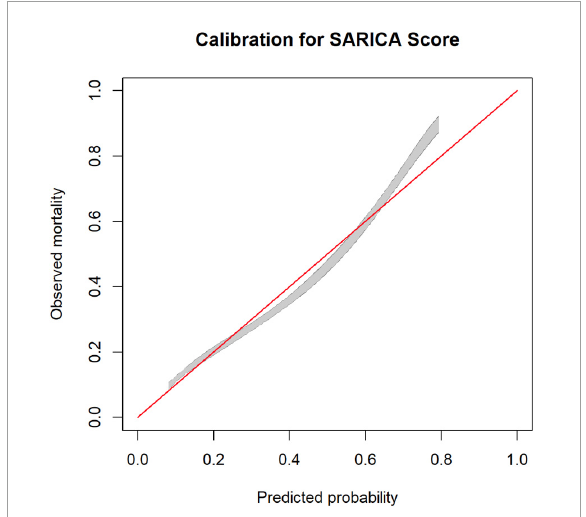
FIGURE3 Calibration plot for SARICA score showing calibration belts (at 80% [gray] and 95% [dark gray] confidence levels).